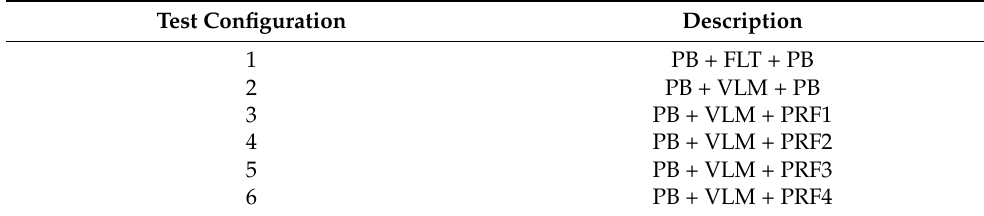
Table 2. Test configurations for the sound reduction index